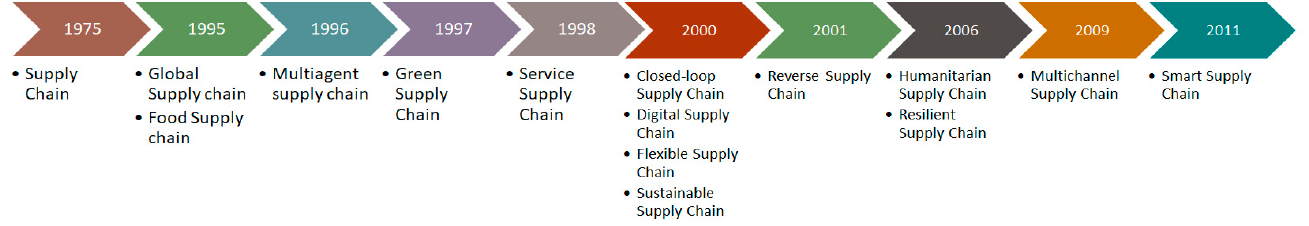
Figure 8. Supply chain trends recognized in own research; own elaboration based on the conducted research.